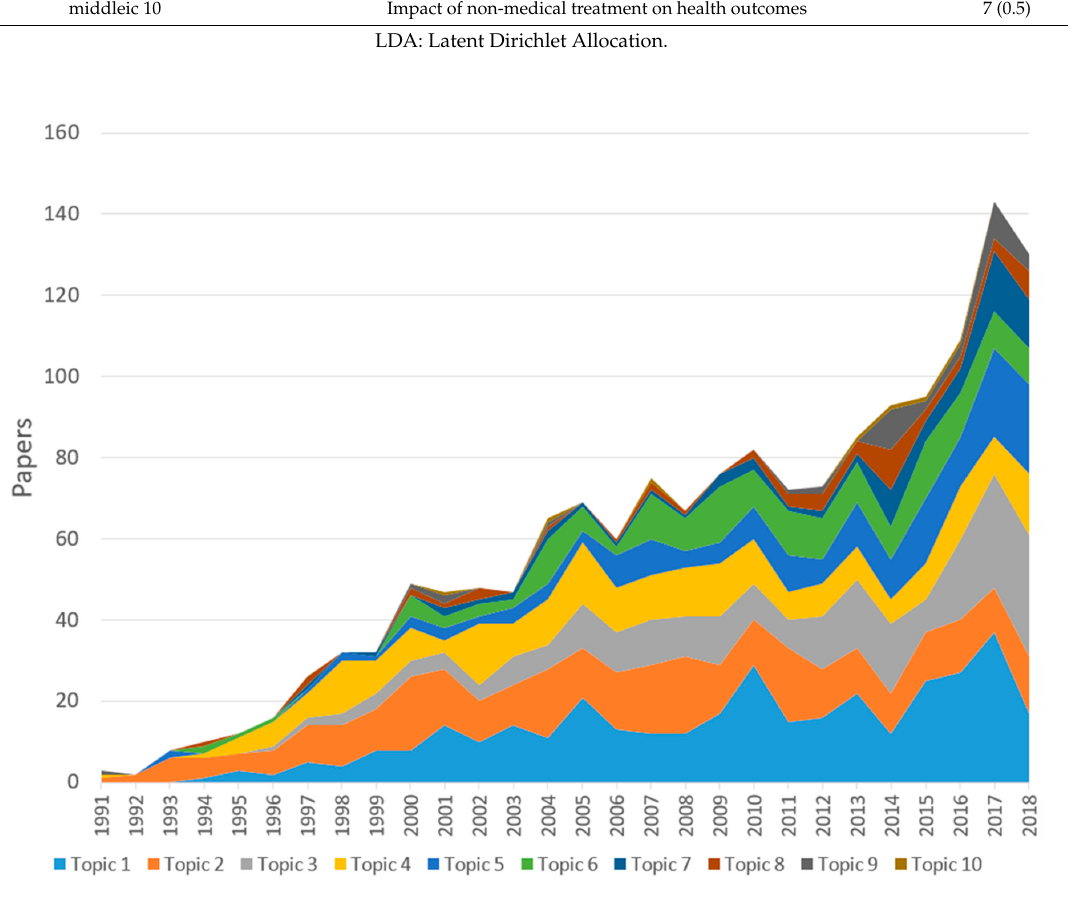
Figure 3. Changes in research topics development.